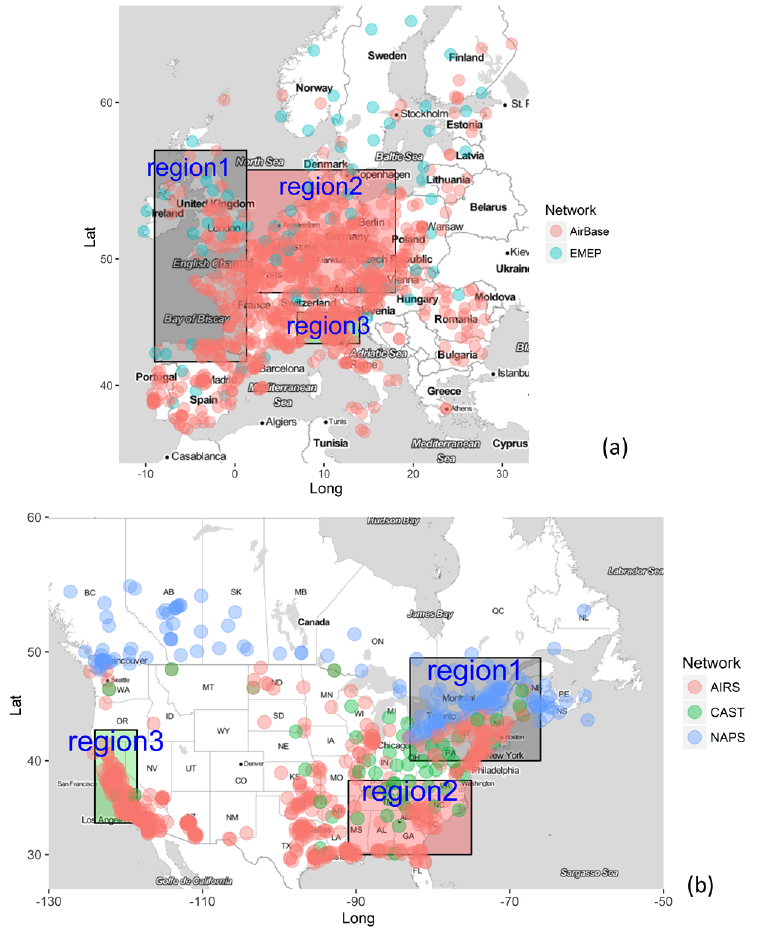
Figure 1. Continental domains and subregions used for analysis. The networks of ozone receptors are also shown.